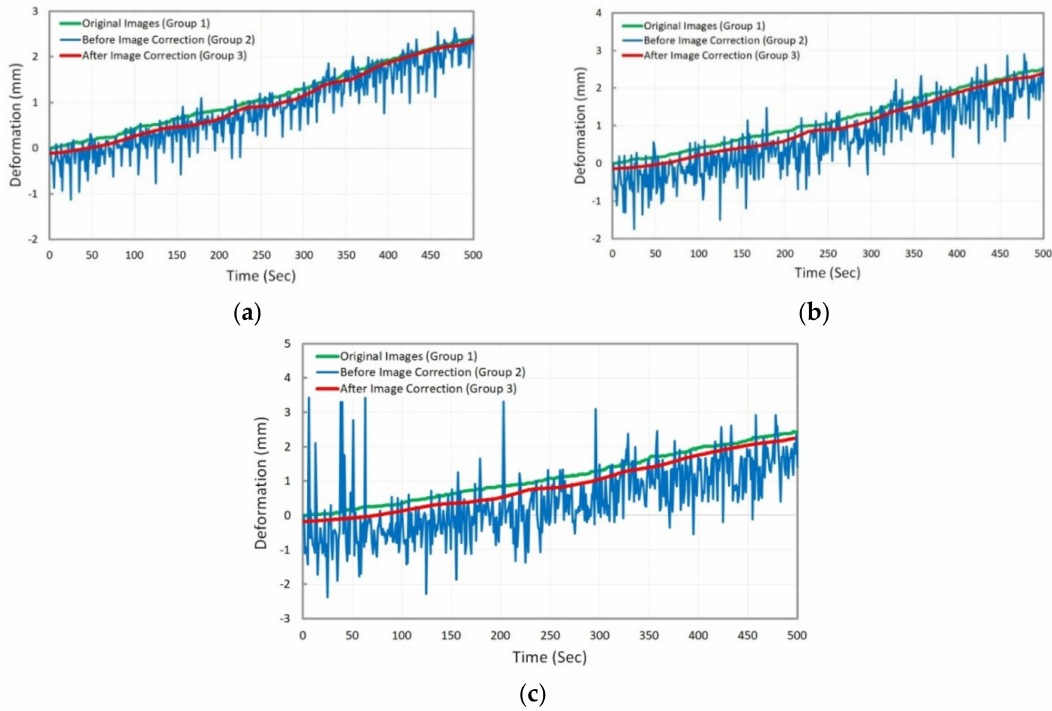
Figure 9. Comparison of deformation results: ( a ) at Target G 2 ; ( b ) at Target G 3 ; ( c ) at Target G 4 .